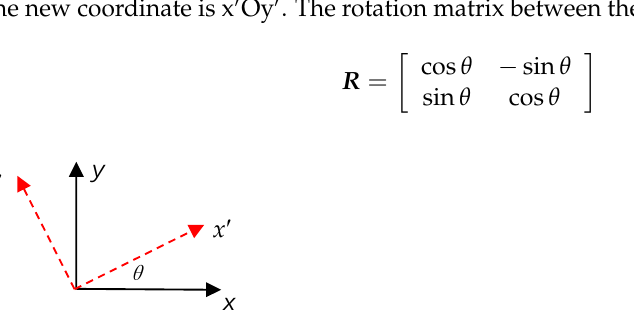
Figure 1. The coordinate transformation in plane.